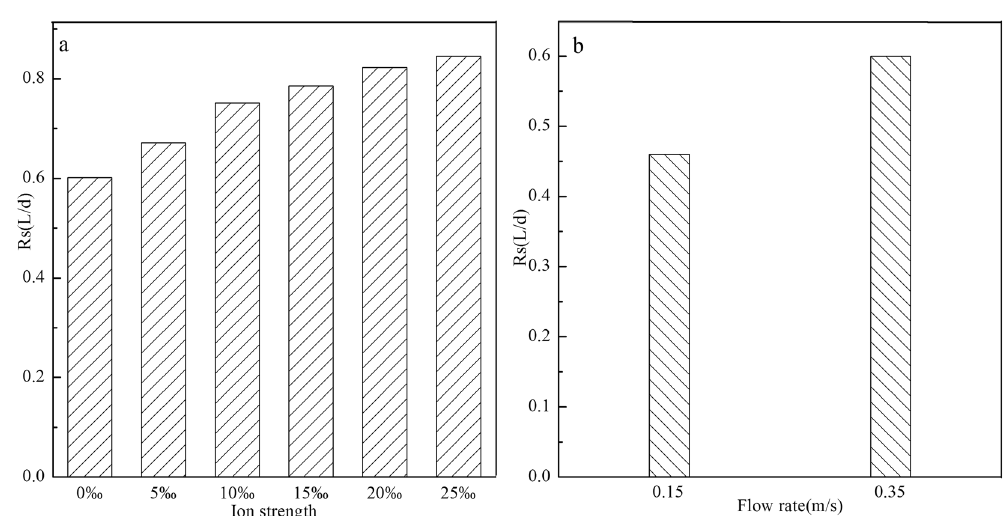
Figure 4. Effects of ion strength ( a ) and flow rate ( b ) on the sampling